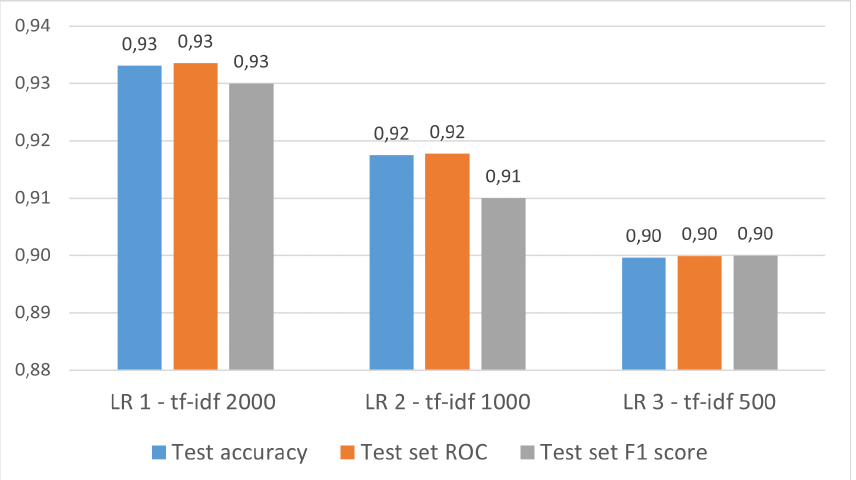
Figure 9. Logistic regression classifier scores for the milk category with varying TF-IDF feature